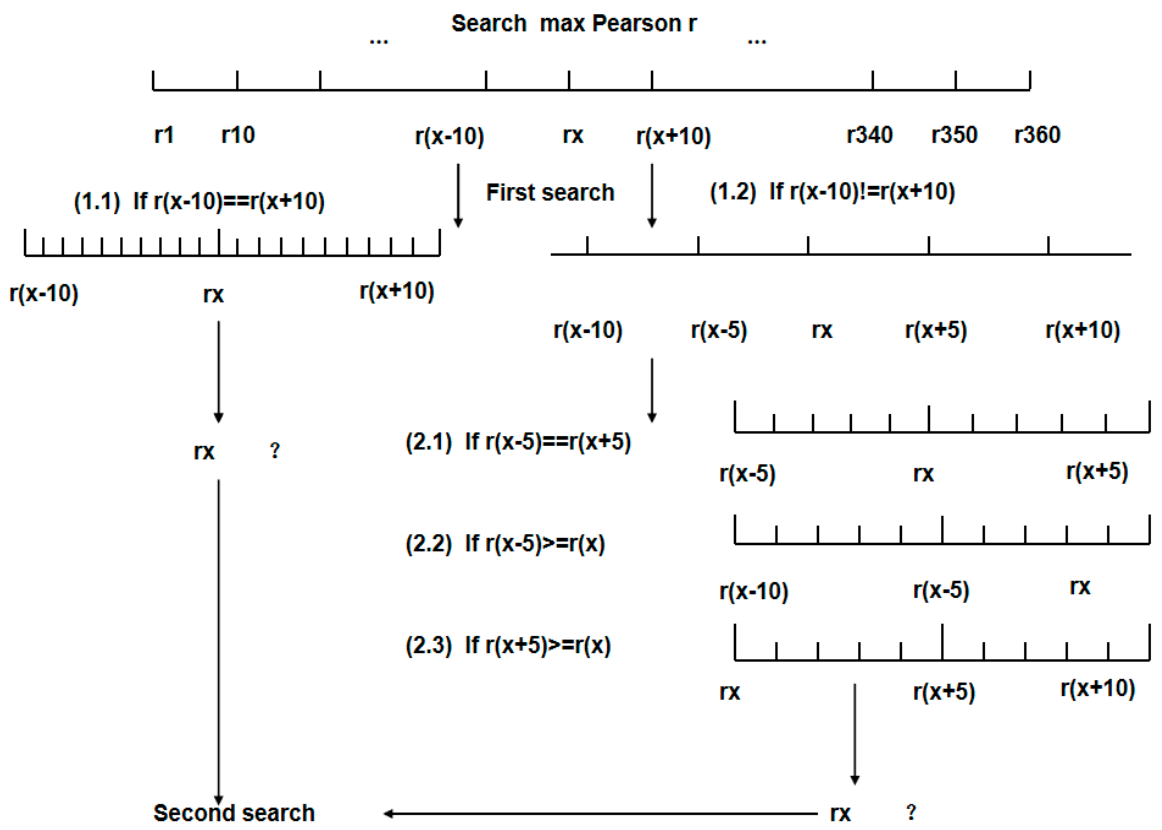
Figure 4. Fuzzy query method for finding the greatest value for the Pearson’s correlation coefficient r between cumulative precipitation and soil moisture content. rx is the x day before the test day.